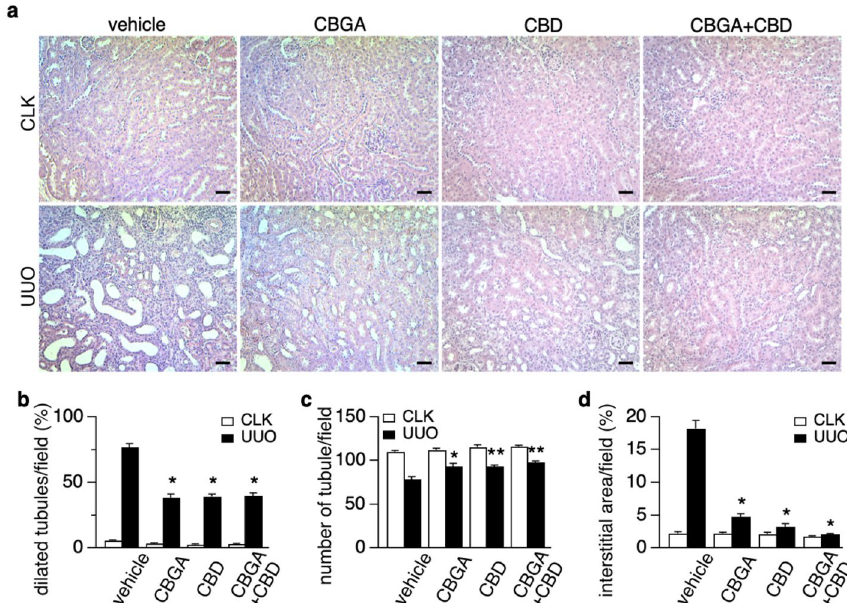
Figure 5. CBGA and CBD protect renal morphology in the UUO kidneys. ( a ) Representative images of HE stainings taken from CLK (upper panels) and UUO (lower panels) kidney sections (magnification × 200) from mice treated with vehicle, CBGA, CBD, CBGA + CBD. Scale bars represent 50 µm. ( b , c ) The number of dilated tubules ( b ) and total tubules ( c ) were counted and evaluated statistically in the CLK (white bars) and UUO kidneys (black bars) at day 7 after UUO. ( d ) The percentage of the interstitial area in the CLK (white bars) and UUO kidneys (black bars) were quantified using the sections stained for collagen type I (see Fig. 6a). *p < 0.05, **p < 0.01 vs. UUO kidneys treated with vehicle